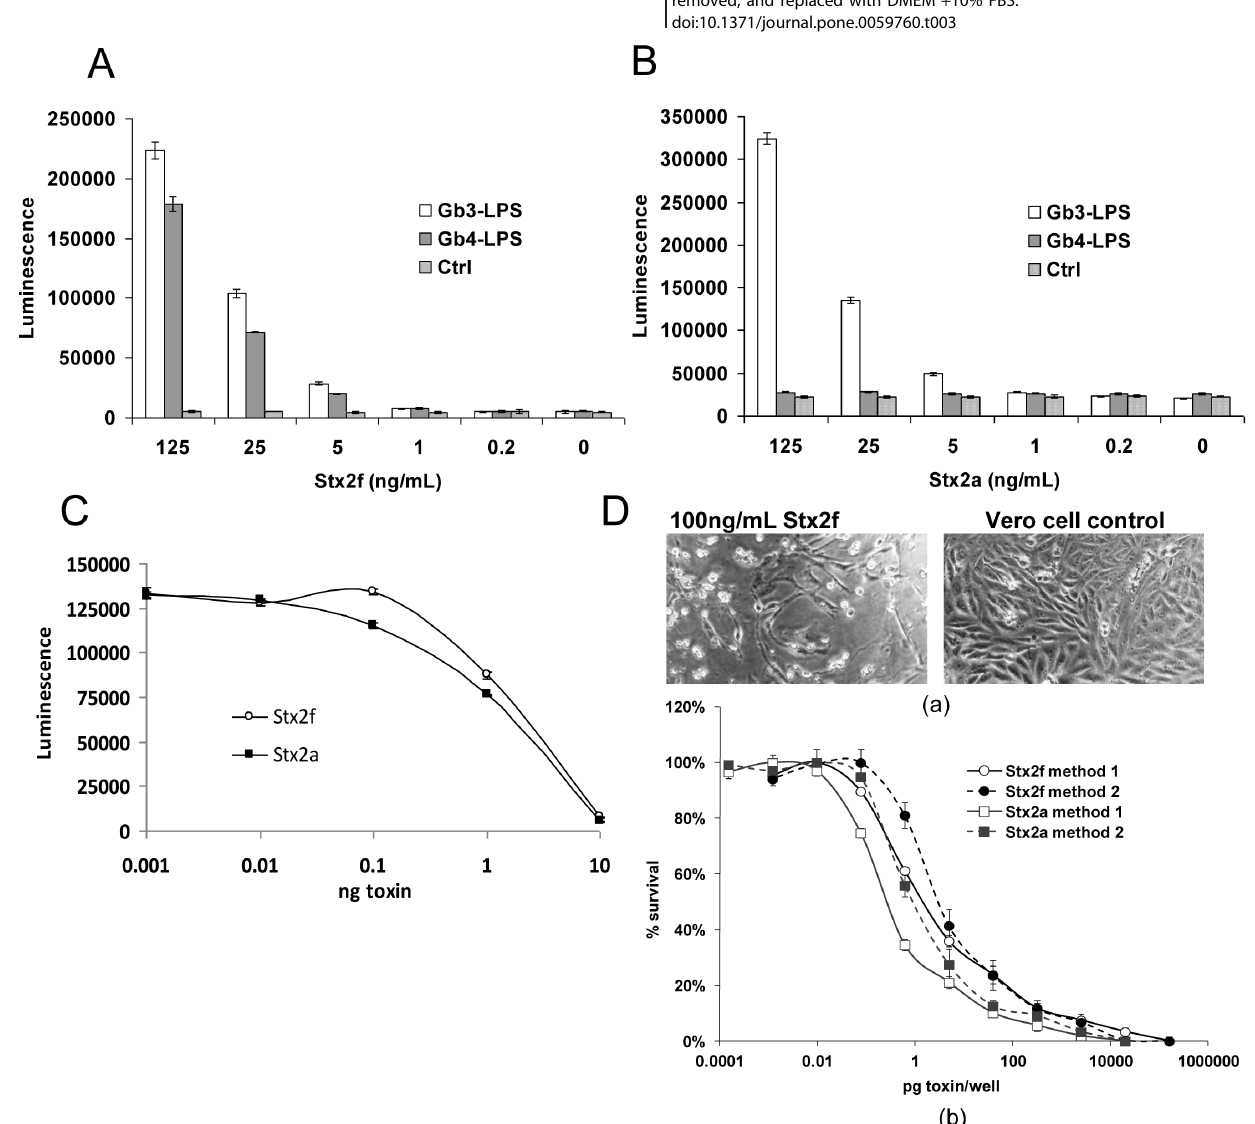
Figure 3. Biochemical properties and cell toxicity of Stx2f. A. Gb3-LPS and Gb4-LPS binding for Stx2f. Binding was measured in an ELISA using E. coli cells expressing Gb3-LPS (Gb3 mimic) or Gb4-LPS (Gb4 mimic), or control cells. A representative experiment is shown (N=4). B. Gb3-LPS and Gb4-LPS binding assay for Stx2a. Binding was measured as in (A). A representative experiment is shown (N=3). C. In vitro translation is inhibited by Stx2f and Stx2a to similar degrees in a rabbit reticulocyte lysate assay. A representative experiment is shown (N=3). D. Stx2f is toxic to Vero cells in culture, but Stx2a is more toxic. Method of treatment (overnight incubation with toxin: Method 1; treatment at 4 u C [1 hour] followed by media exchange: Method 2) is important when calculating CD 50 values. Stx2a is more toxic than Stx2f using both methods: by 5-fold using Method 1 (0.3 and 1.6 pg/well, respectively), and 3-fold using Method 2 (1.1 and 3.4 pg/well, respectively) (N=4).